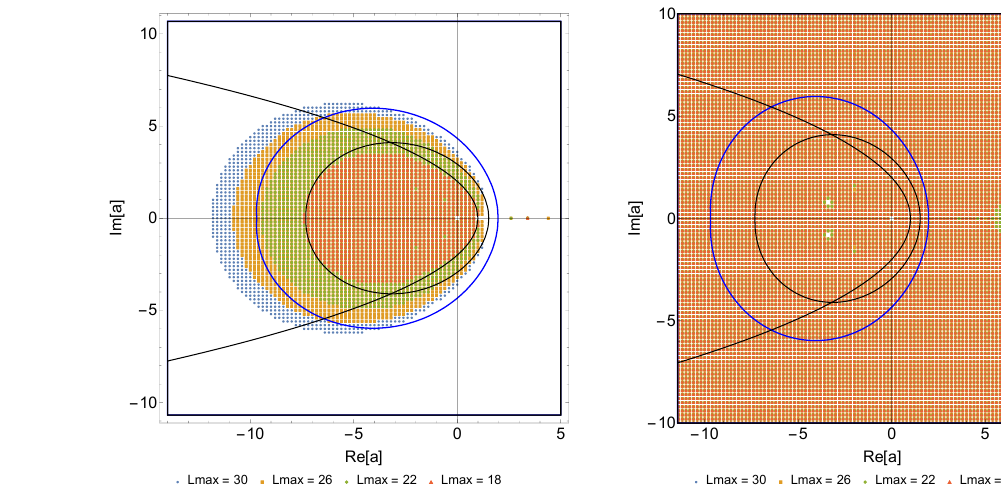
(d) Feynman block expansion of amplitude with k max = 40 . We consider s 1 = 23 / 3 , shown in blue contour and black lines are boundary of the overall domain.